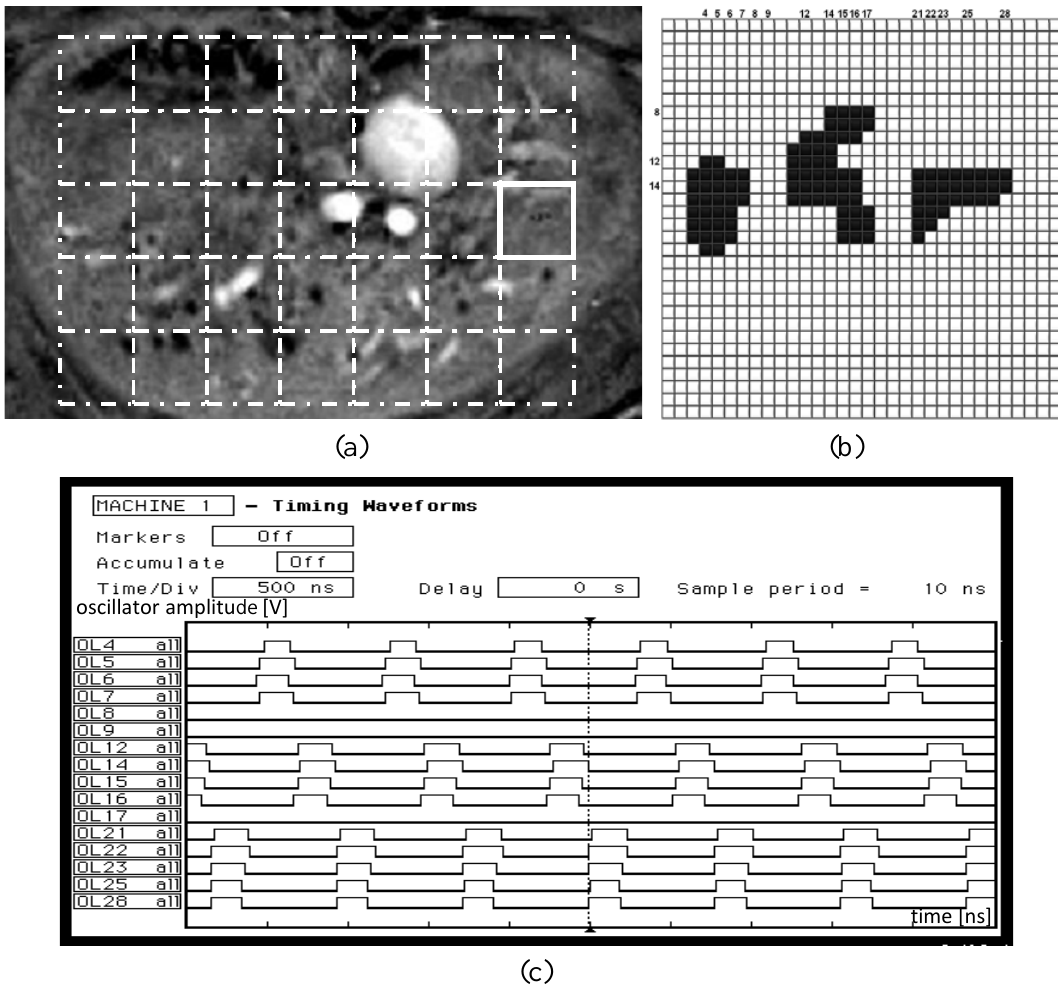
Figure 12. Sample MR image of rat liver with pancreatic islets (a) , dashed squares mark regions for network chip labeling. Sample region loaded into a chip (b) , marked by solid line in (a). Selected oscillators output waveforms (defined by column numbers in b) for line 14 (c)